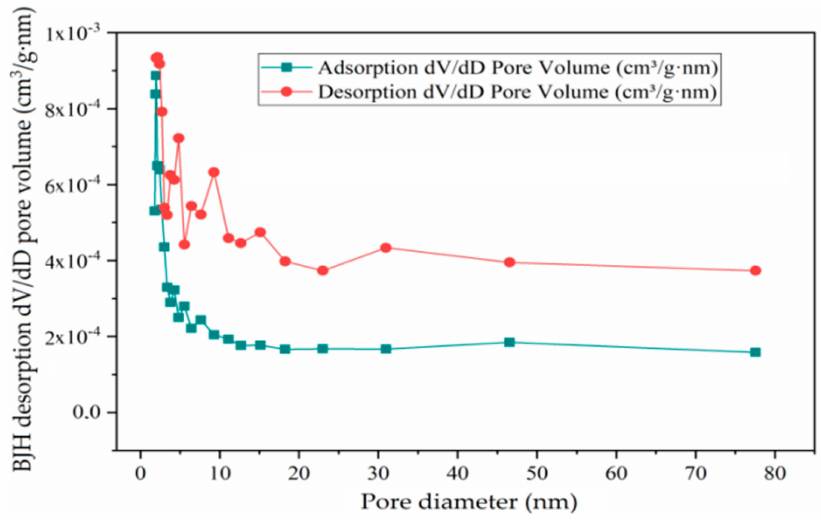
Figure 15. BJH adsorption and desorption of Ni-CoAl 2 O 3 catalyst pore